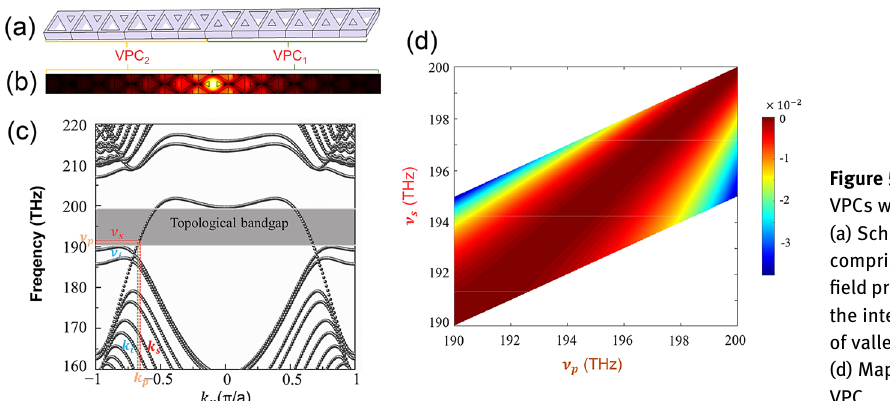
Figure 5: Topological valley kink states in VPCs with different interfaces. (a) Schema of proposed VPC structure